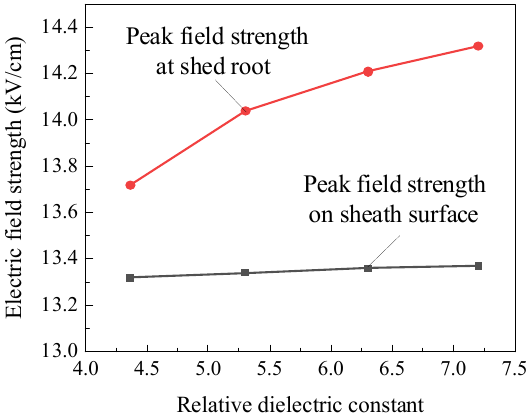
Figure 8. Field strength as a function of dielectric constant.